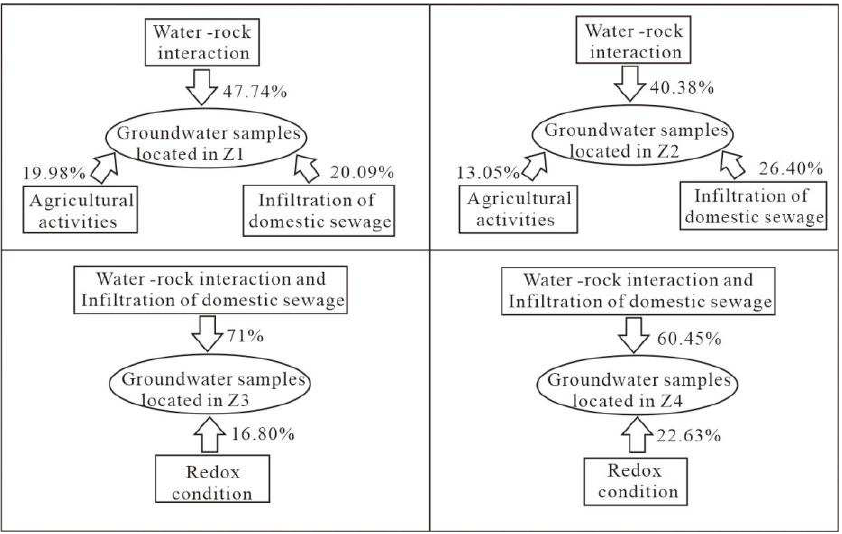
Figure 8. Factors dominating the groundwater chemical characteristics in different zones in MXP.